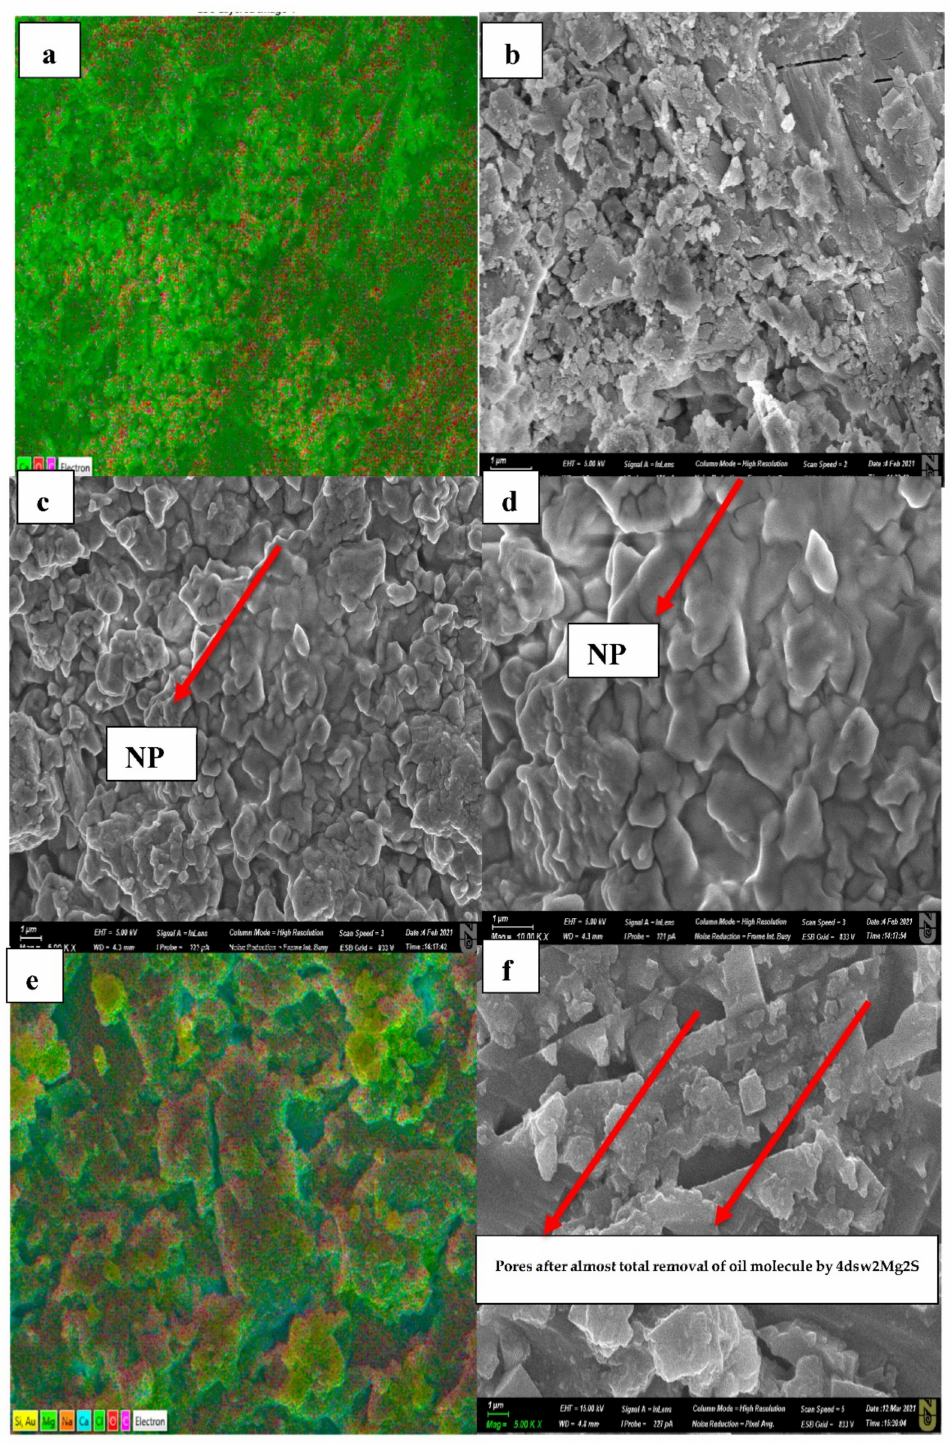
Figure 19. ( a , b ) SEM images of newly cut limestone; ( c , d ) deposition of SiO 2 on the oil-wet rock surface after soaking in hybrid LSW/NF; ( e , f ) deposition of different ions and NPs after total removal of oil from the rock surfaces by